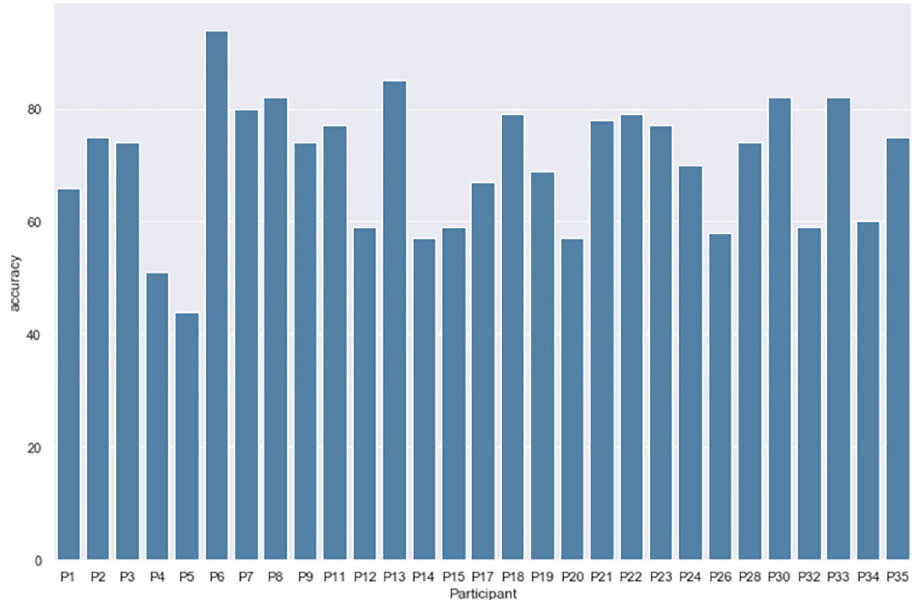
Fig 6. The performance of the AdaBoost classifier with 6 selected features using the Leave-one-subject-out cross- validation method.